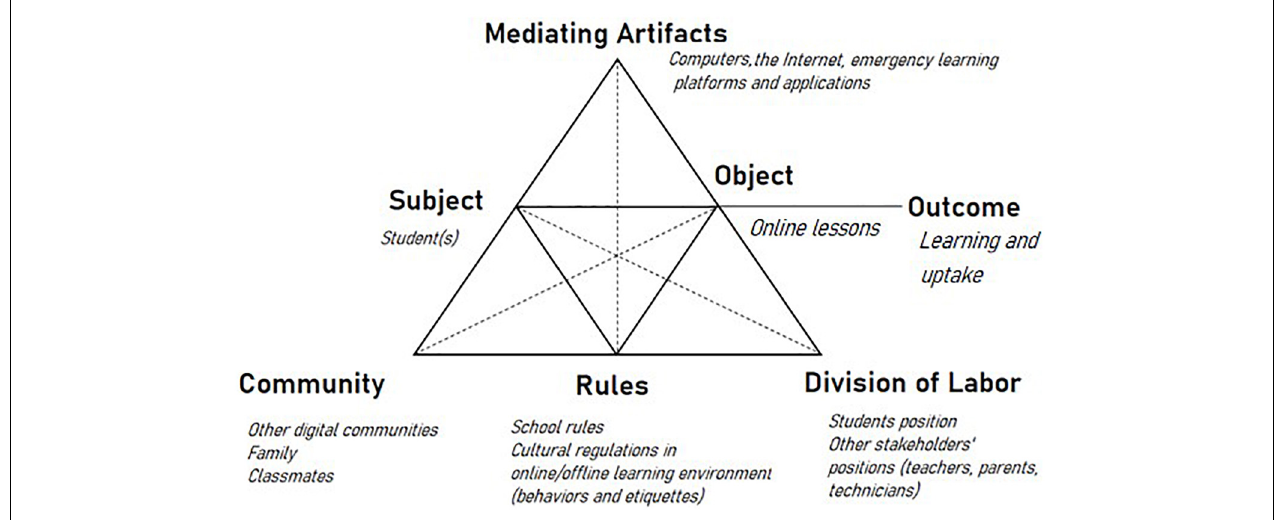
FIGURE 1 | Model of students’ activities in the online emergency classroom [adapted from Engeström